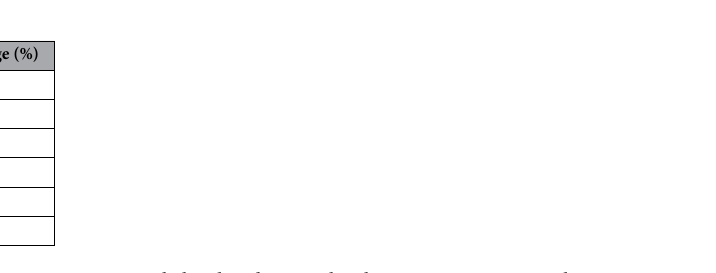
Table 3. Reported classification accuracy at patch-level and image-level using various